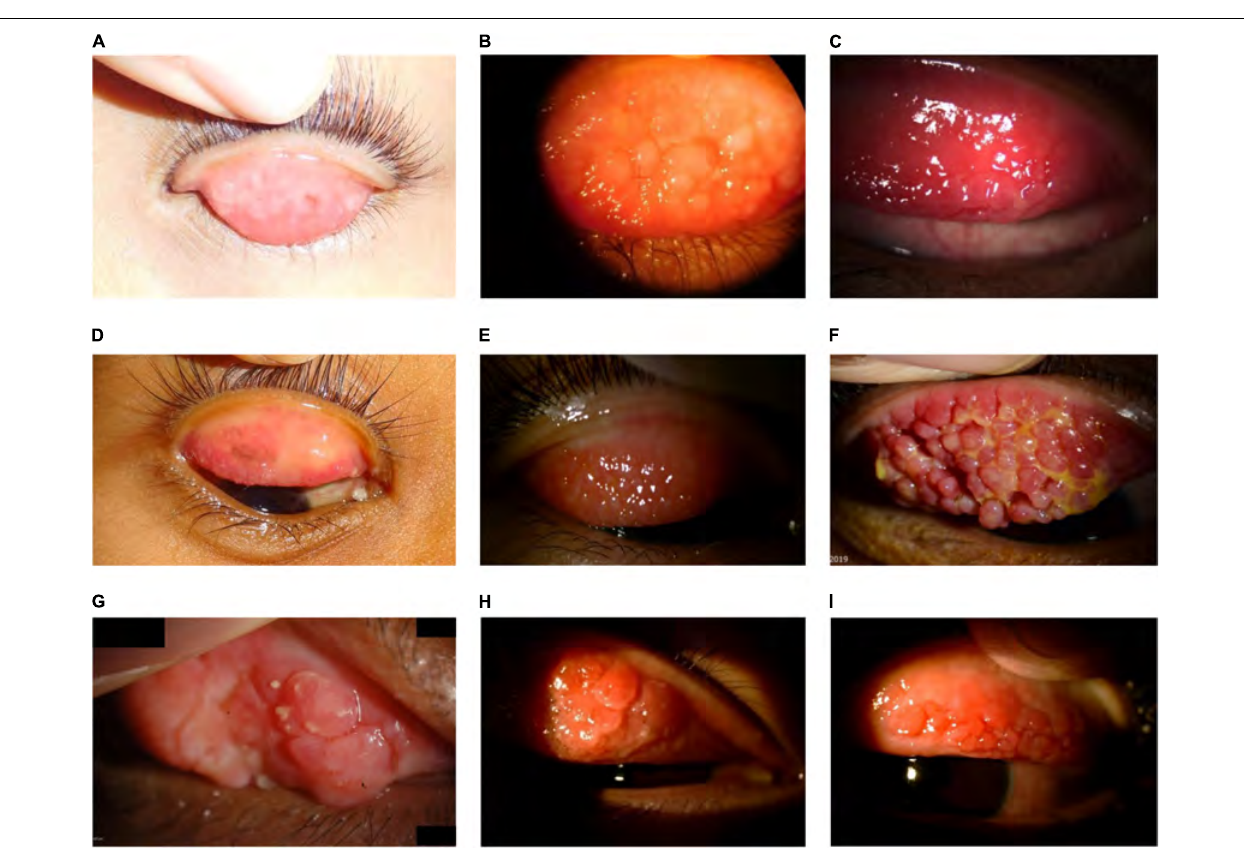
FIGURE 6 | Large cobblestone papillae. Upper tarsal giant papillae are typical of VKC. These have characteristically flattened tops which sometimes demonstrate stain with fluorescein. Giant papillae can sometimes be seen near the limbus and, while relatively uncommon, symblepharon formation and conjunctival fibrosis can occur. (A–D) Images courtesy of Florence Manurung; (E) image courtesy of Douglas K. Lam; (F) image courtesy of Jodhbir S. Mehta; (G) image courtesy of Wei-Li Chen; (H-I) images courtesy of Leo Seo